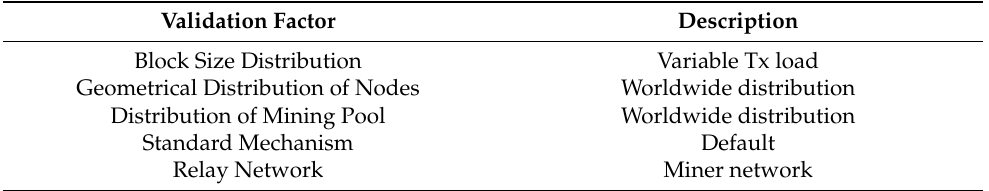
Table 4. PoW Blockchain Validation Factors.